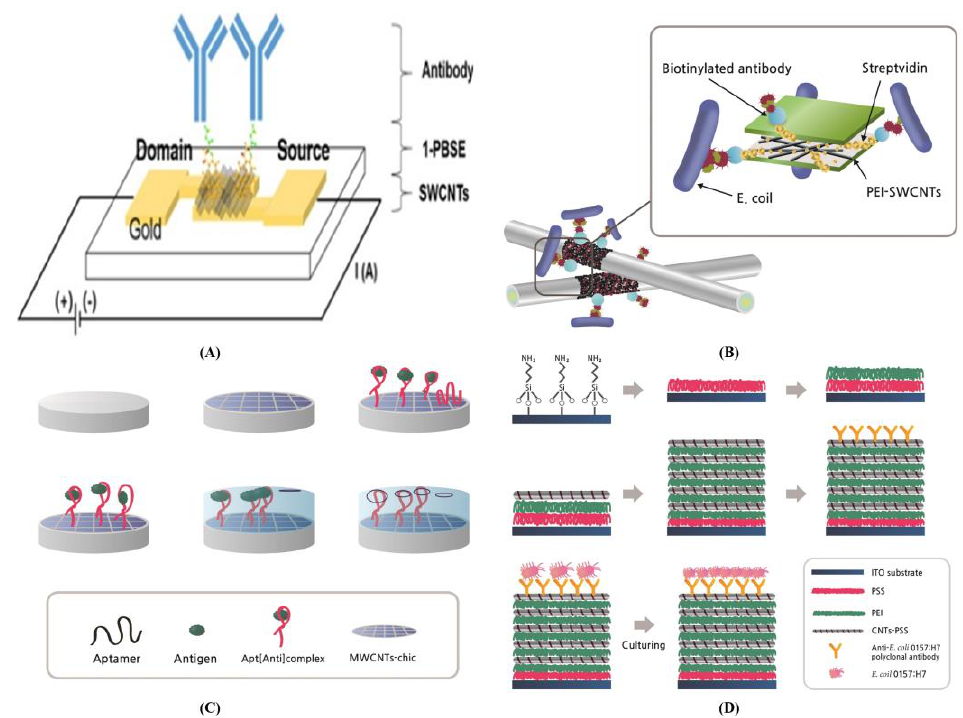
Figure 8. CNT-based biosensors for detecting food pathogen microbes. ( A ) FET biosensor with antibody immobilized with SWCNTs coated with 1-PBASE for the detection of Staphylococcus aureus [99]; ( B ) SWCNT-based biosensor with a disposable bio-nano combinatorial junction with gold tungsten wires covered with polyethylenimine (PEI) and SWCNTs for the detection of Escherichia coli K-12 [100]; ( C ) Nano-biosensor using Apt [Anti]complex/MWCNTs-Chit/GCE for HCV core antigen detection [102]; ( D ) SWCNTs multilayer biosensor using coupling microfluidic chip-based LAMP for the detection of E. coli O157:H7 [103].